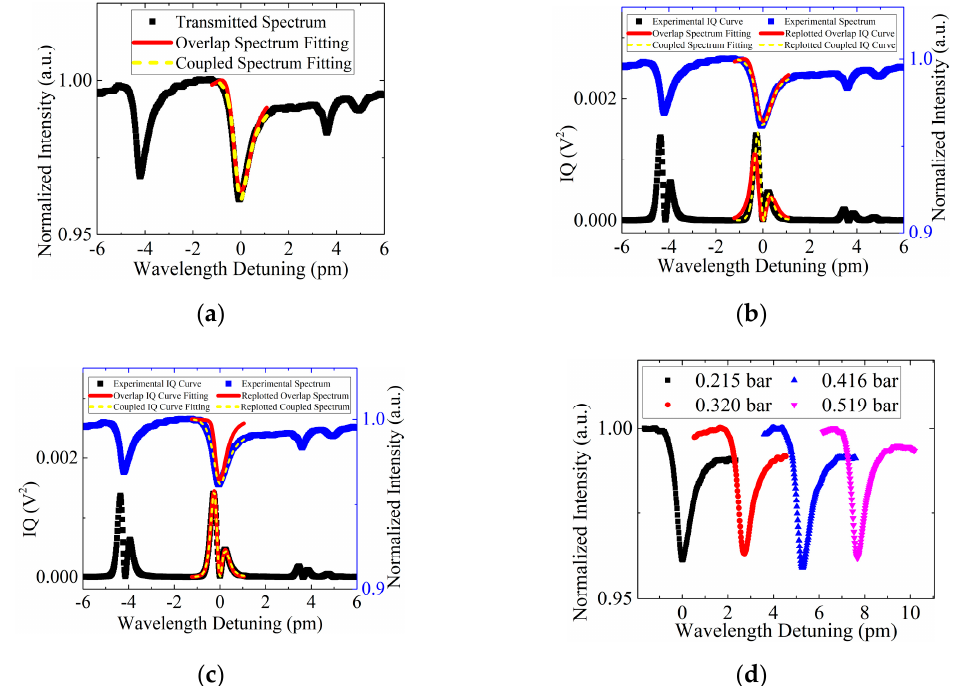
Figure 3. ( a ) Experimental (black scattered line) and fitted spectrum (red solid line, g = 0; yellow dashed line, g = 1.20 × 10 4 MHz). ( b ) Experimental spectrum (blue scattered line) and IQ curve (black scattered line), fitted spectrum and replotted IQ curves (red solid line, g = 0 MHz; yellow dashed line g = 1.20 × 10 4 MHz). ( c ) Experimental spectrum (blue scattered line) and IQ curve (black scattered line), fitted IQ curve and replotted resonances (red solid line g = 0 MHz; yellow dashed line g = 1.20 × 10 4 MHz). ( d ) Asymmetrical resonance shifts as the MBR internal pressure (0.215, 0.320, 0.416, and 0.519 bar) increases. Table 2. Weakly coupled resonance fitting results.